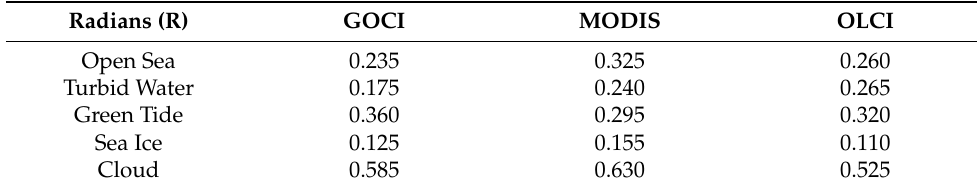
Table 3. Threshold values for each type of object.